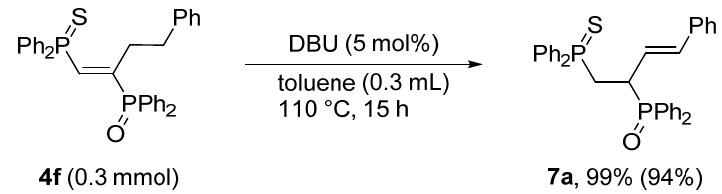
Figure 1. Crystal structure of 6b with numbered atoms. Ellipsoids are shown at the 50% probability level. Selected interatomic distances (Å) and angles (deg): P1–S1, 1.9577(4); P1–C11, 1.8171(12); P1–